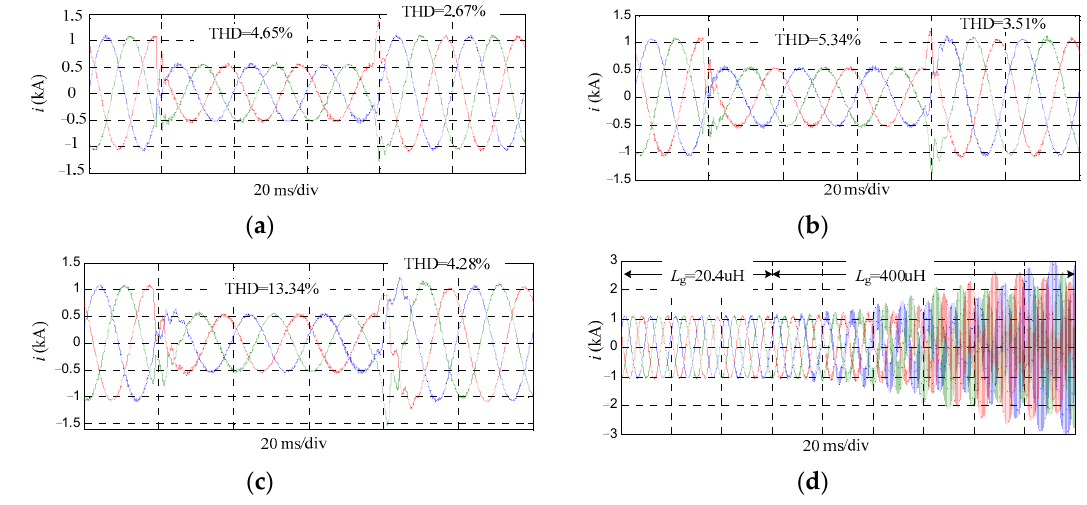
Figure 13. Simulation results of the new inverter for different SCRs. ( a ) L g = 20.4 μ H (SCR = 45). ( b ) L g = 61 μ H (SCR = 15). ( c ) L g = 184 μ mH (SCR = 5). ( d ) L g = 460 μ H (SCR = 2).